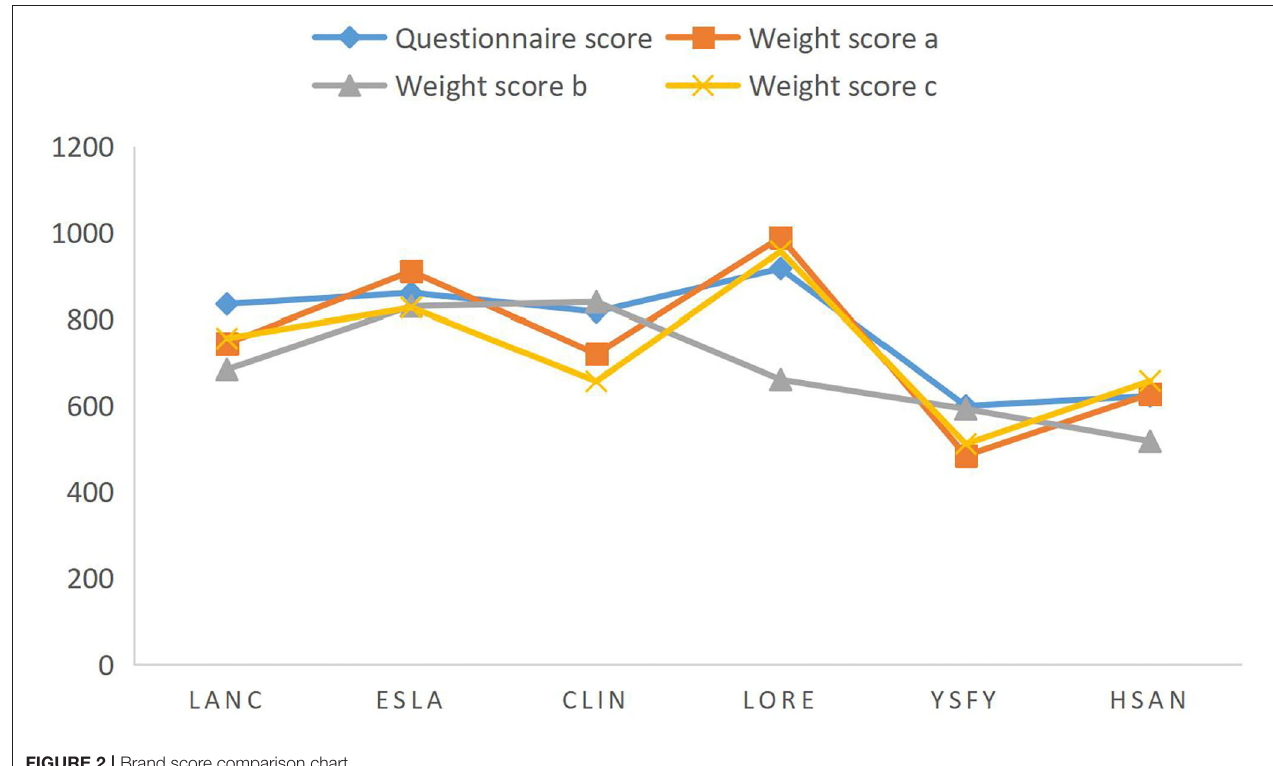
FIGURE 2 | Brand score comparison